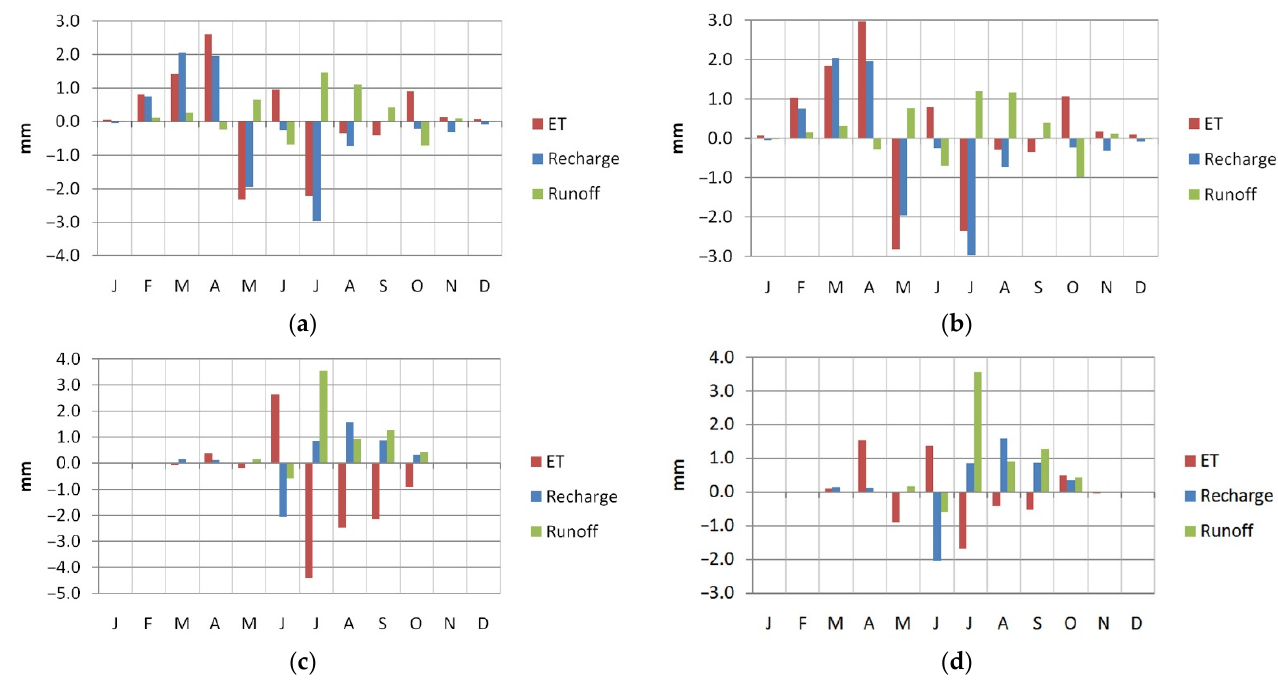
Figure 6. Average monthly output difference of hydrological parameters from the non-burning model subtracted from the model considering burning. Top to bottom panels show burning differences for: ( a ) all land classes, ( b ) grassland, ( c ) savanna, and ( d ) cropland.